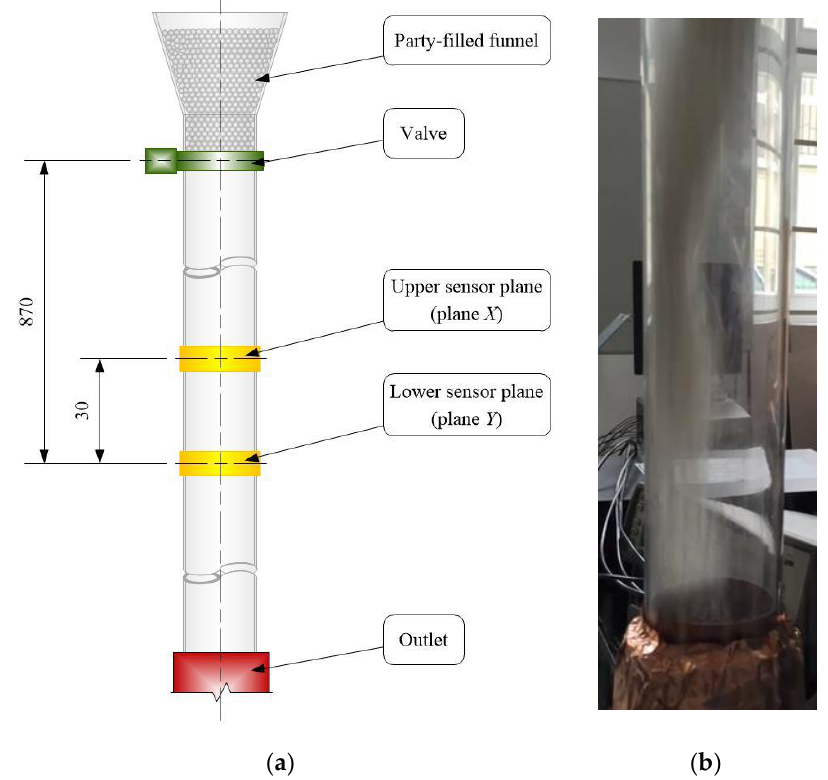
Figure 5. Gravity drop rig schematic ( a ), image of gravity flow (above upper sensor plane) ( b ).